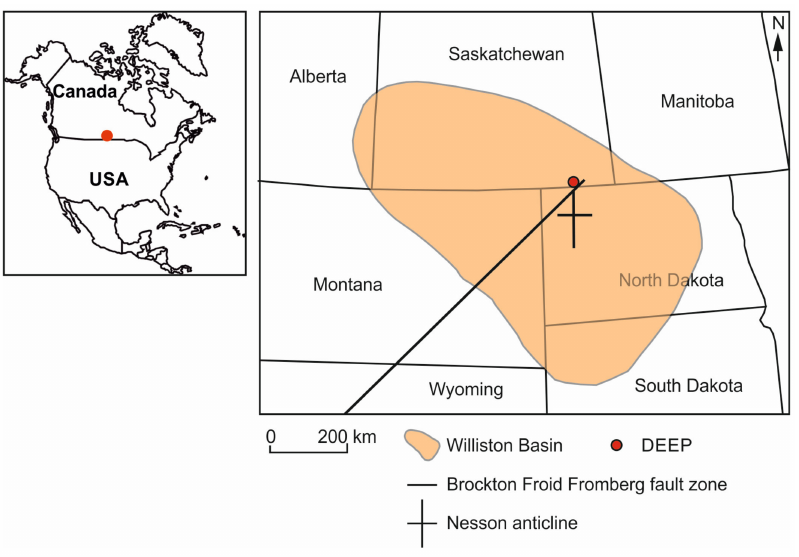
Figure 9. Williston Basin and DEEP project (red dot) location